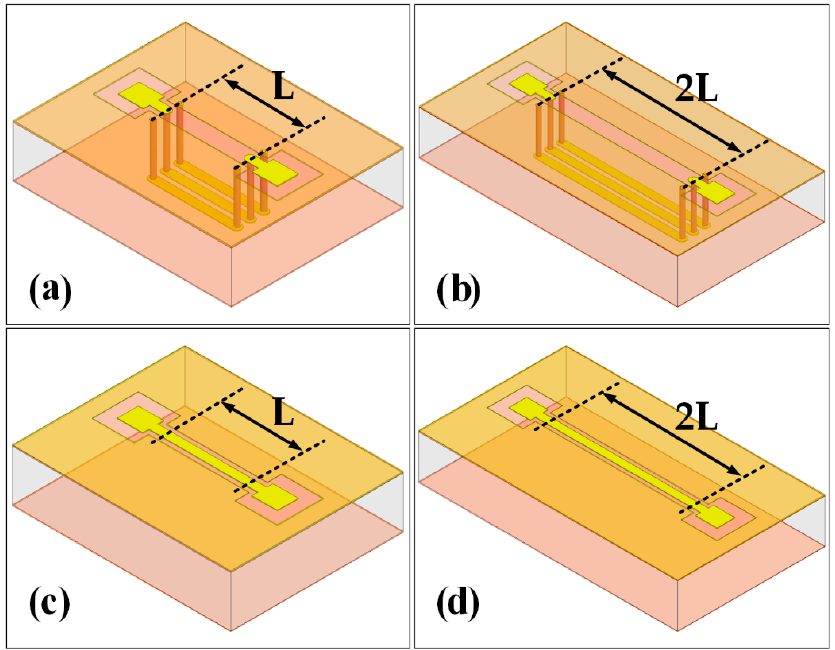
Figure 14. 3D models of the L-2L de-embedding structures. ( a ) TSVs and RDLs (L), ( b ) TSVs and RDLs (2L), ( c ) only RDLs (L), ( d ) only RDLs (2L).